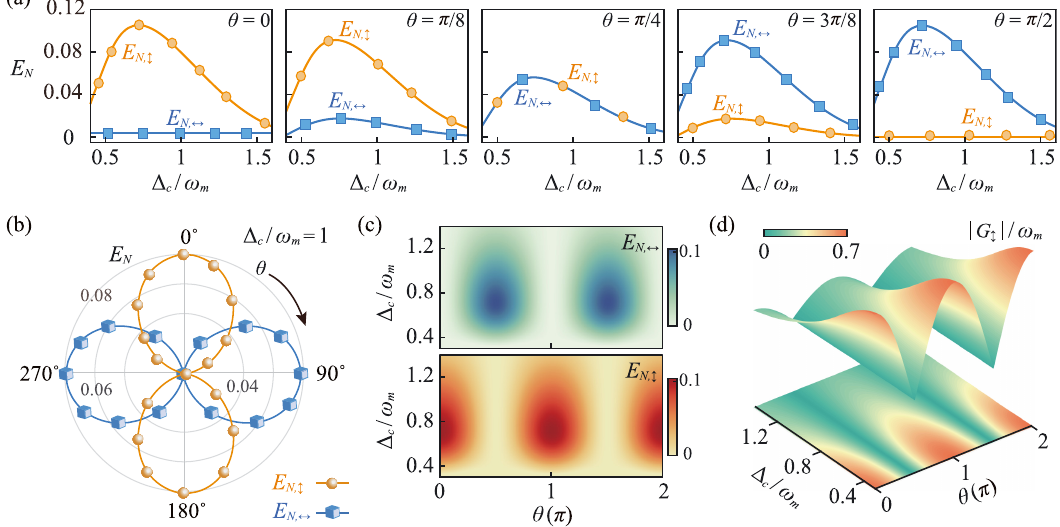
Figure 2: Polarization-controlled optomechanical entanglement switch within the intracavity mode. (a) The logarithmic negativity E of the TE and TM modes versus the scaled optical detuning Δ N , j 𝜃 . (b) The logarithmic negativity E of the TE and TM modes versus the polarization angle 𝜃 in polar coordinates, with the optical detuning N , j Δ ∕ 𝜔 = 1. E and E demonstrate a complementary distribution with the variation of the polarization angle 𝜃 . (c) Density plot of E c m N , ↕ N , ↔ and the polarization angle 𝜃 . By tuning the polarization angle, an adjustable coherent COM function of the scaled optical detuning Δ c entanglement switch between the TE and TM modes could be achieved. (d) The effective COM coupling | G ↕ | of the TE mode versus the scaled and the polarization angle 𝜃 optical detuning Δ c